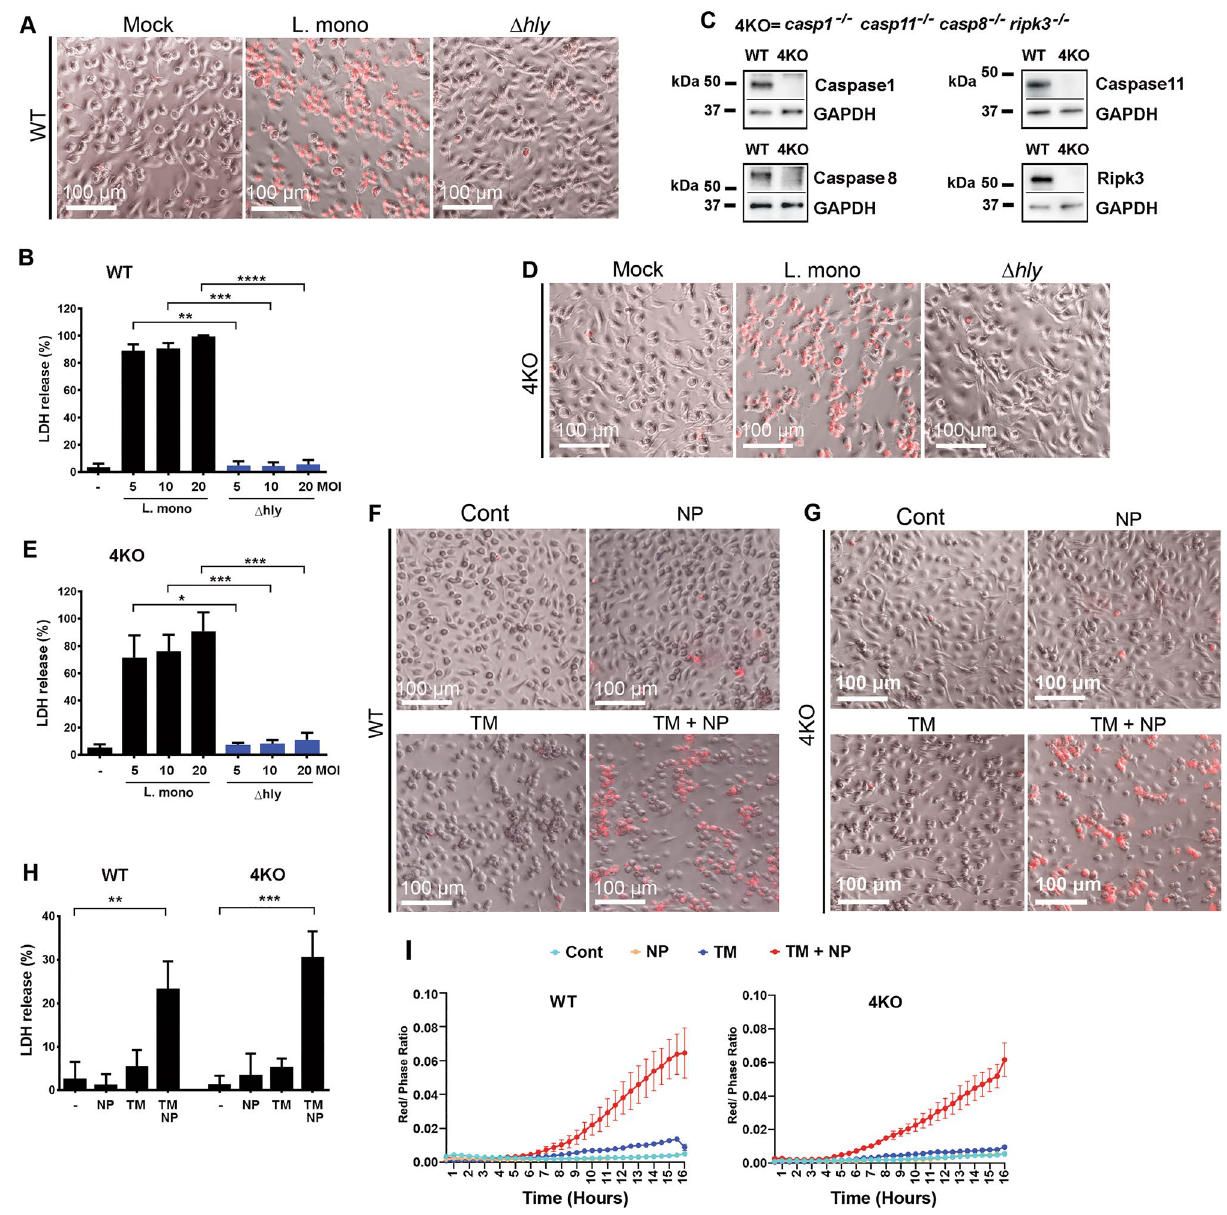
Figure 1. L.monocytogenes or synthetic nanoparticles trigger necrotic death of Mϕs from WT mice and mice with compound homozygous deficiency in caspases-1, -8, -11, and RIPK3. (A) BMDMs from WT mice undergo necrosis after infection with L. monocytogenes (MOI 5) as determined by the addition of PI (red) into the culture medium. Its isogenic strain (Δ hly ), unable to penetrate endosomal compartment, does not cause necrotic death in BMDM. Images of representative fields acquired using bright- field and red channels are shown. Scale bar is 100 μm. N = 3. (B) Lactate dehydrogenase (LDH) release from BMDMs after infection with wild-type L. monocytogenes (L. mono) or its isogenic strain (Δ hly ) at indicated MOIs. Data are presented as Mean ± SD, N = 3. (C) Western blot analysis of expression of Caspases-1, -8, -11, and RIPK3 in WT and compound homozygous deficient mice (4KO). GAPDH–glyceraldehyde-3-phosphate dehydrogenase. N = 5. (D) BMDMs from 4KO mice undergo necrosis after infection with L. monocytogenes (MOI 5), while isogenic strain (Δ hly ) does not cause necrotic death in 4KO BMDM. Images of representative fields acquired using bright-field and red channels are shown. Scale bar is 100 μm. N = 3. (E) LDH release from 4KO BMDMs after infection with wild-type L. monocytogenes (L. mono) or its isogenic strain at indicated MOIs. N = 3. (F) BMDM from WT mice undergo necrosis after exposure to TM and NP as determined by the addition of PI (red) into the culture medium. Images of representative fields of Mϕs treated with DMSO (Cont), TM, NP, or with TM and NP combination, acquired using bright-field and red channels are shown. Scale bar is 100 μm. N = 20. (G) BMDM from 4KO mice undergo necrosis after exposure to TM and NP as determined by the addition of PI (red) into the culture medium. Images of representative fields of Mϕs treated with DMSO (Cont), TM, NP, or with TM and NP combination, acquired using bright-field and red channels are shown. Scale bar is 100 μm. N = 20. (H) LDH release from WT or 4KO BMDM after their treatment with NP, tunicamycin (TM), and their combination. N = 4. (I) Kinetics of necrotic death induction in WT and 4KO BMDM after their exposure to indicated stimuli and determined by IncuCyte continuous image acquisition. Necrotic cell death is assessed as ratio of red object confluence divided by phase object confluence and is depicted on the y-axis. Representative data are shown. N =